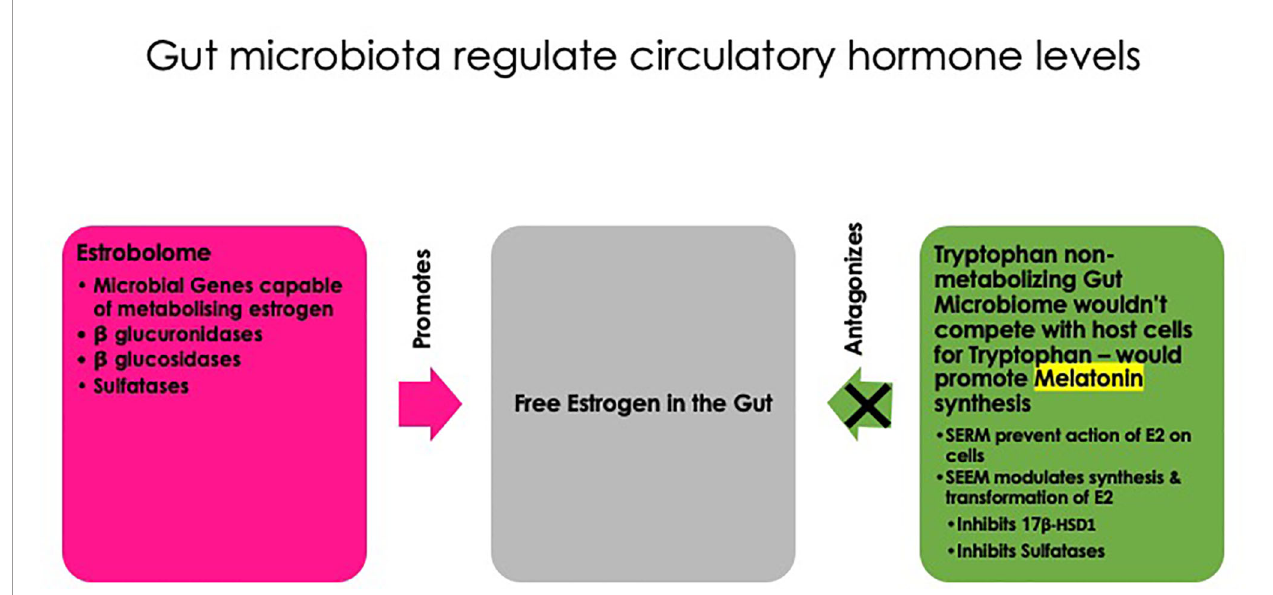
FIGURE 3 | Estrogen metabolism by the gut microbiome. At one end of the spectrum is the “ estrobolome ”— the overall gut microbial genes which can metabolize estrogens: e.g ., b -glucuronidases and sulfatases. These enzymes deconjugate estrogens (both parent and metabolites) and release free estrogens in the gut lumen which can get absorbed into the circulation. At the other end is tryptophan non-metabolizing microbiome ( e.g ., Klebsiella spp.) — which doesn ’ t compete with the host cells for tryptophan and thereby promotes the synthesis of melatonin in the gut. Melatonin antagonizes estrogens by acting as a selective estrogen receptor modulator (SERM) and a selective estrogen enzyme modulator (SEEM) by inhibiting enzymes which synthesize estradiol, viz ., 17 b -hydroxysteroid dehydrogenase 1 (17 b -HSD1), sulfatases, and aromatase (reproduced from: Jayshree R. S. and Kumar R. V. (2019) Contribution of the Gut and Vaginal Microbiomes to Gynecological Cancers. In: Mehta S., Singla A. (eds) Preventive Oncology for the Gynecologist. Springer, Singapore.